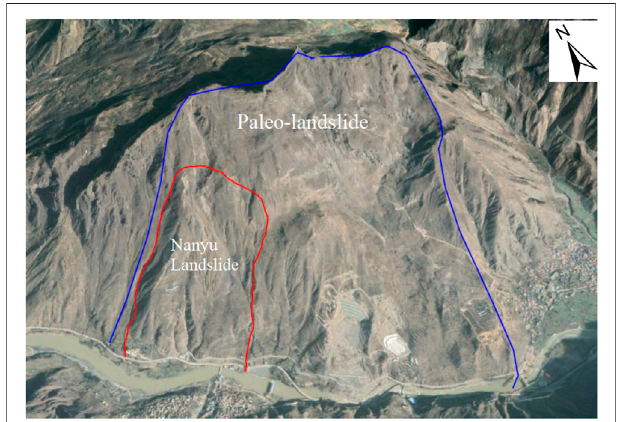
FIGURE 15 | Optical image of Nanyu